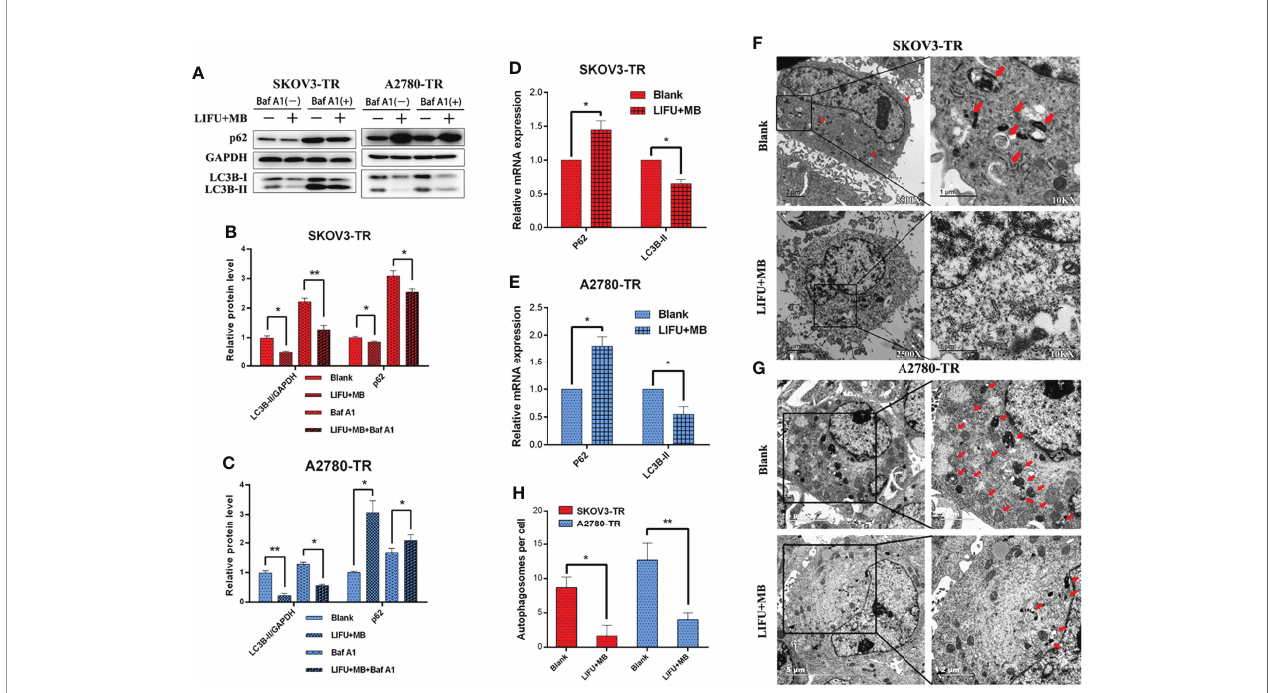
FIGURE 7 | Autophagy detection in SKOV3-TR and A2780-TR cells after LIFU+MB. (A – C) Western blot showed p62(SQSTM1) and LC3B levels in SKOV3-TR and A2780-TR cells. (D, E) The expression of autophagy was determined by qRT-PCR. (F – H) Analysis of autophagy after LIFU+MB in SKOV3-TR and A2780-TR cells.